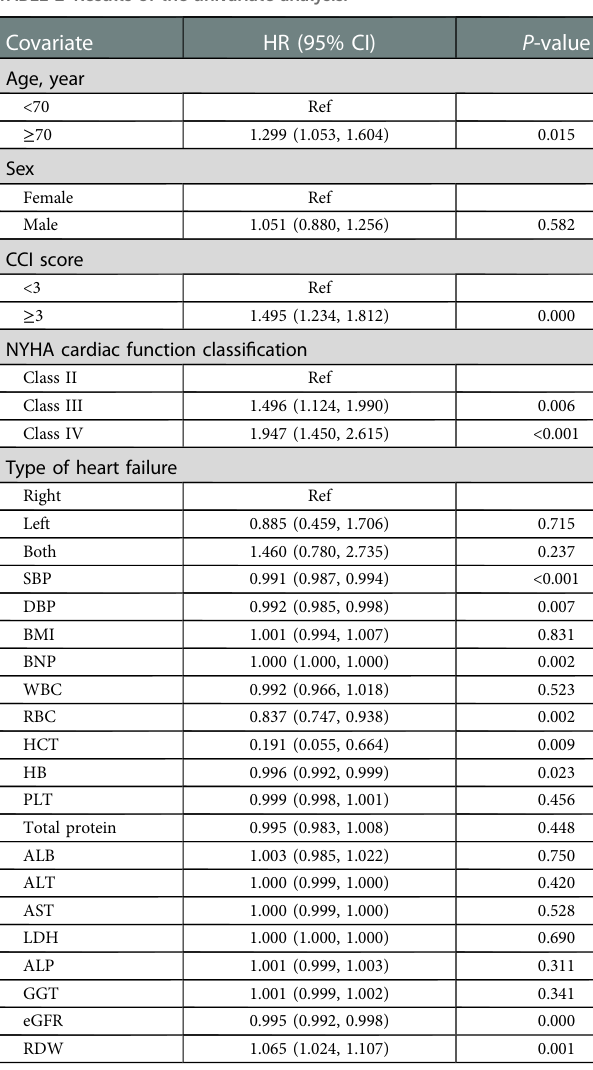
TABLE 2 Results of the univariate analysis.